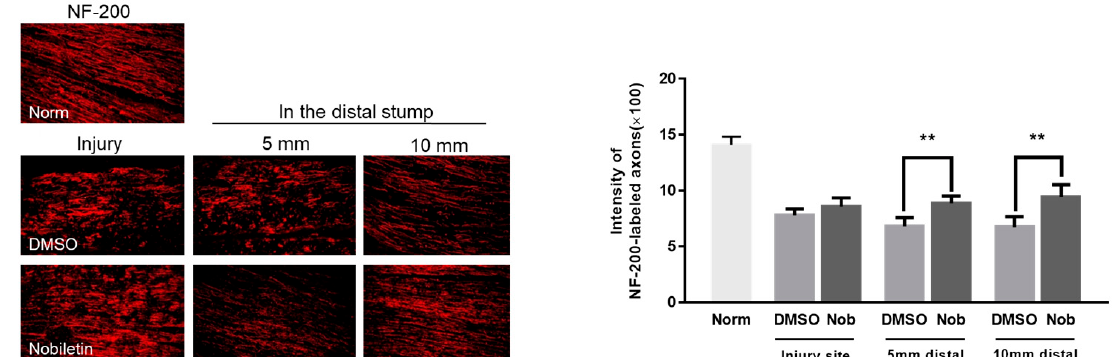
Figure 5. Nobiletin increased axonal elongation 2 weeks after SNI. Sciatic nerves were used for immunofluorescence staining with anti-NF-200 antibody. The nobiletin treated group showed apparently stronger staining of NF-200 in the segment 5 and 10 mm distal to the injury site than DMSO treated group. In each experiment, the intensity of axons stained with NF-200 was measured at injury site, 3 and 5 mm distal to the damage site from three or four nonconsecutive sections. There was a significant difference between DMSO- and nobiletin-treated groups ( n = 10, this experiment were assigned to normal control ( n = 2), vehicle and nobiletin-treated groups ( n = 4, each). Norm, normal group; NF-200, neurofilamen-200. ** p < 0.01 compared to the DMSO-treated group.